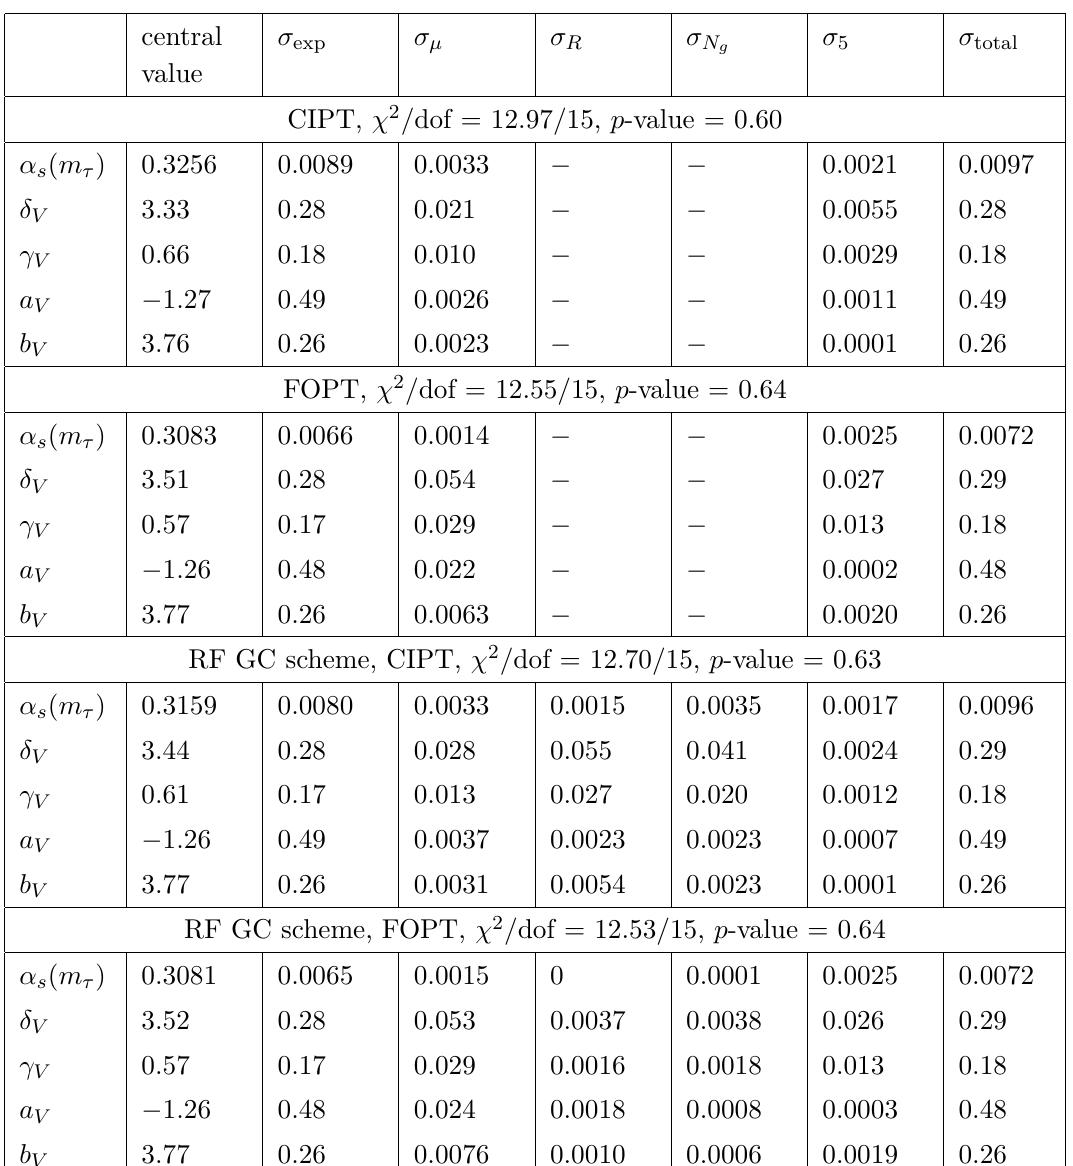
Table 4 . Fitted parameters from the improved τ vector-isovector spectral function of ref. [12] for CIPT and FOPT in the MS GC scheme and in the RF GC scheme. For the latter case we use N g = 0 . 57 ± 0 . 23 . The uncertainty σ c reflects the variation of the 6-loop coefficient as in 5 , 1 eq. (2.15), while σ µ and σ R refer to variations of the strong-coupling renormalization scale µ and of the IR subtraction scale R as described in the text. The values for σ µ , σ 5 , σ R , and σ N are half g the difference between the maximum and minimum values obtained from the ξ , c 5 , 1 , R , and N g variations, respectively, using the central values for the remaining parameters. The parameters b V and γ V are given in units of GeV − 2 ; a V and b V are denoted α V and β V in ref.